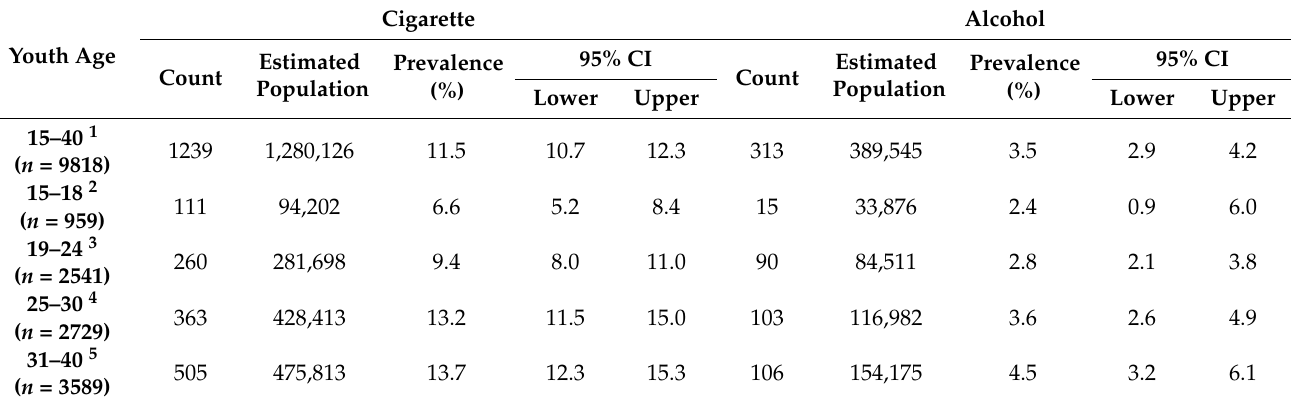
Table 4. Prevalence of current substance abuse by type according to age